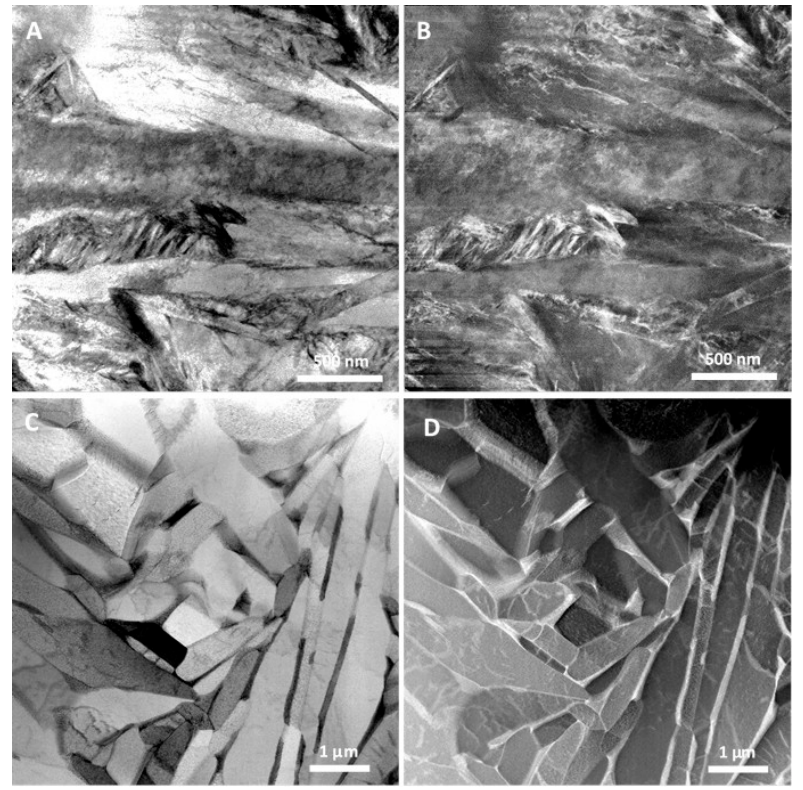
Figure 4. Scanning Transmission Electron Microscopy (STEM) images of samples #AP and #TT in bright-field (BF) and dark-field (DF) mode: A ) #AP–BF; B ) #AP–DF; C ) #TT–BF; D ) #TT–DF.